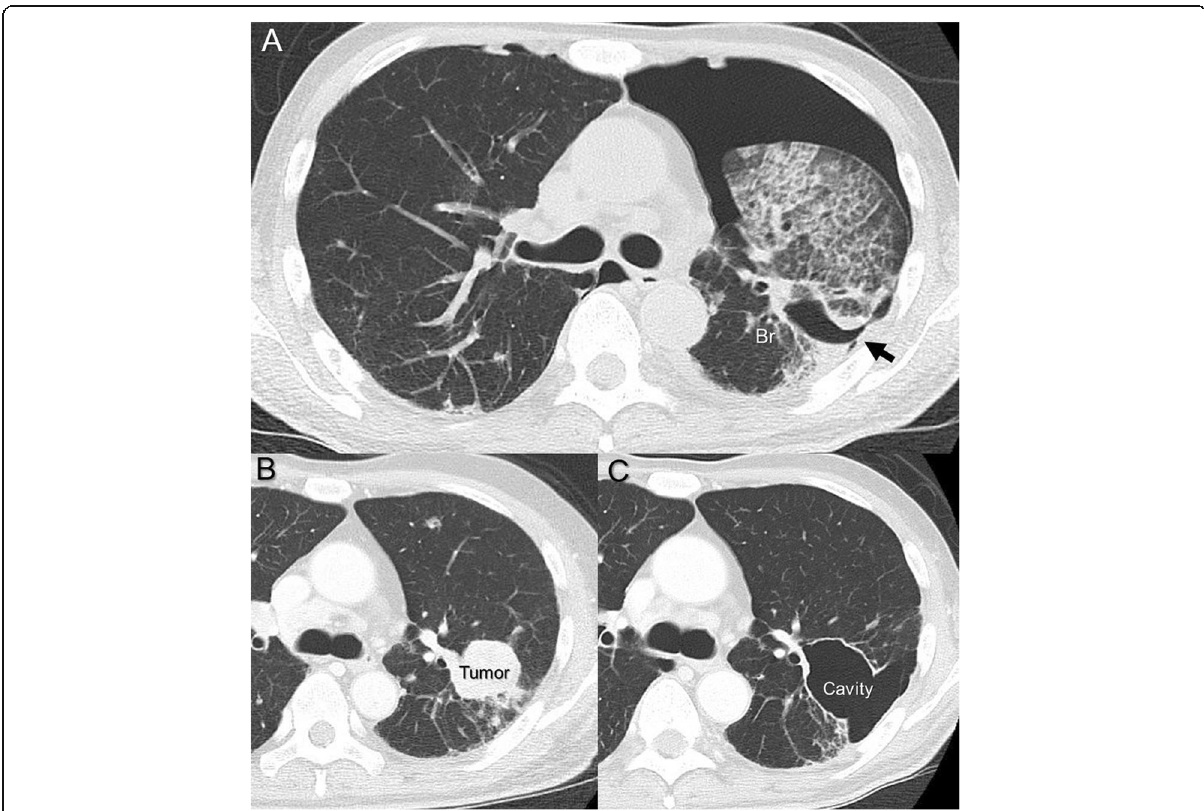
Fig. 1 Chest computed tomography (CT) revealing left pneumothorax and a pleural defect (black arrow) in the left upper lobe (LUL) ( a ). CT before axitinib therapy initiation showing a nodule in the LUL ( b ). CT after the therapy showing a cavity that developed at the same site as the tumor ( c ). Br, bronchus